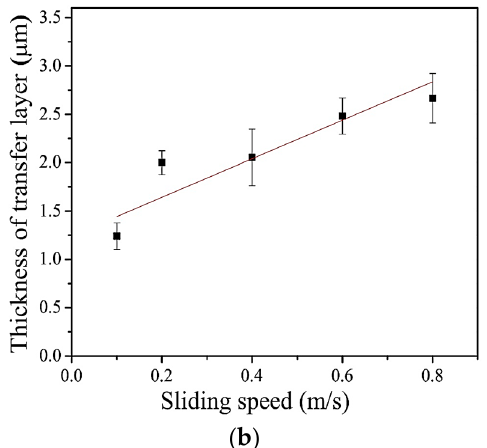
Figure 6. ( a ) The height distribution mappings of transfer layers formed under different sliding speeds; ( b ) The average transfer layer thickness vs. sliding speed.